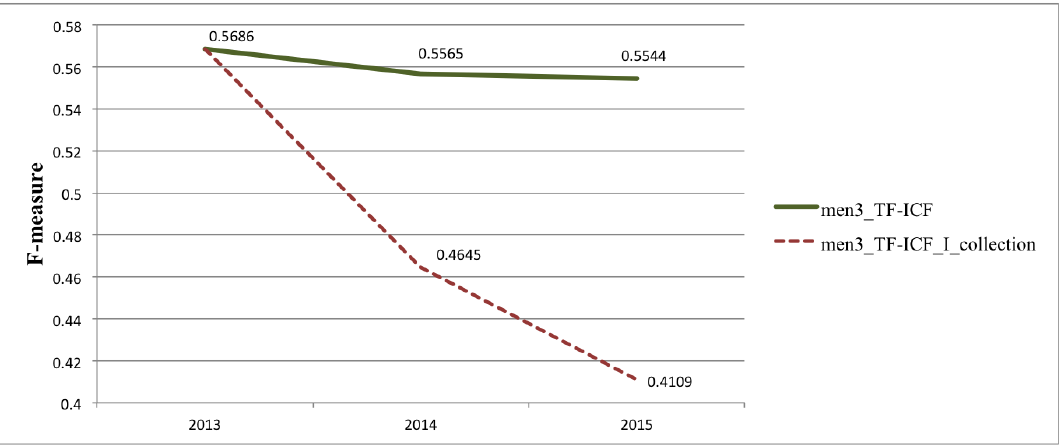
Figure 2. F-measure with dynamic updates of the lexicon of the training collection (solid line) and without (dash